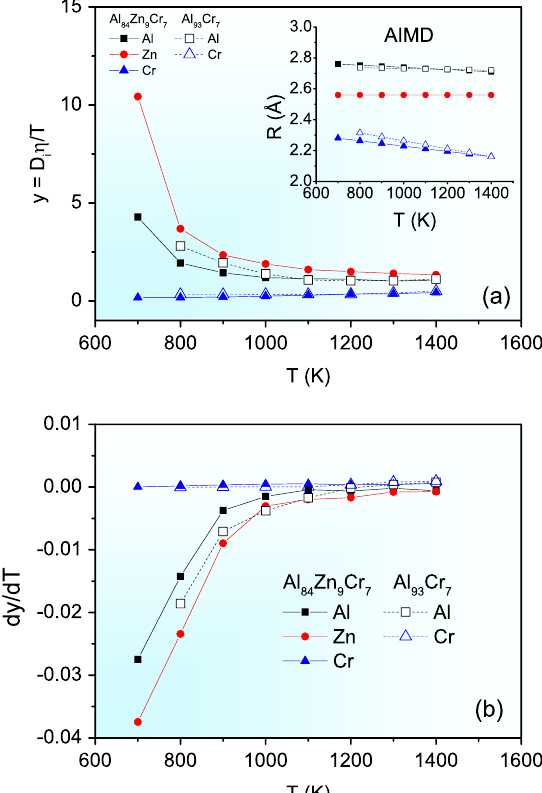
Fig. 4 a Temperature evolution of the Stokes − Einstein ratio y = D i η / T for Al and Cr atoms in Al − Cr binary alloy and Al, Zn, and Cr atoms in Al − Zn − Cr ternary alloy. Inset: corresponding radius R obtained from AIMD partial pair-distribution functions. b Temperature derivative d y /d T for Al and Cr atoms in Al − Zn binary alloy and Al, Zn, and Cr atoms in Al − Zn − Cr ternary alloy